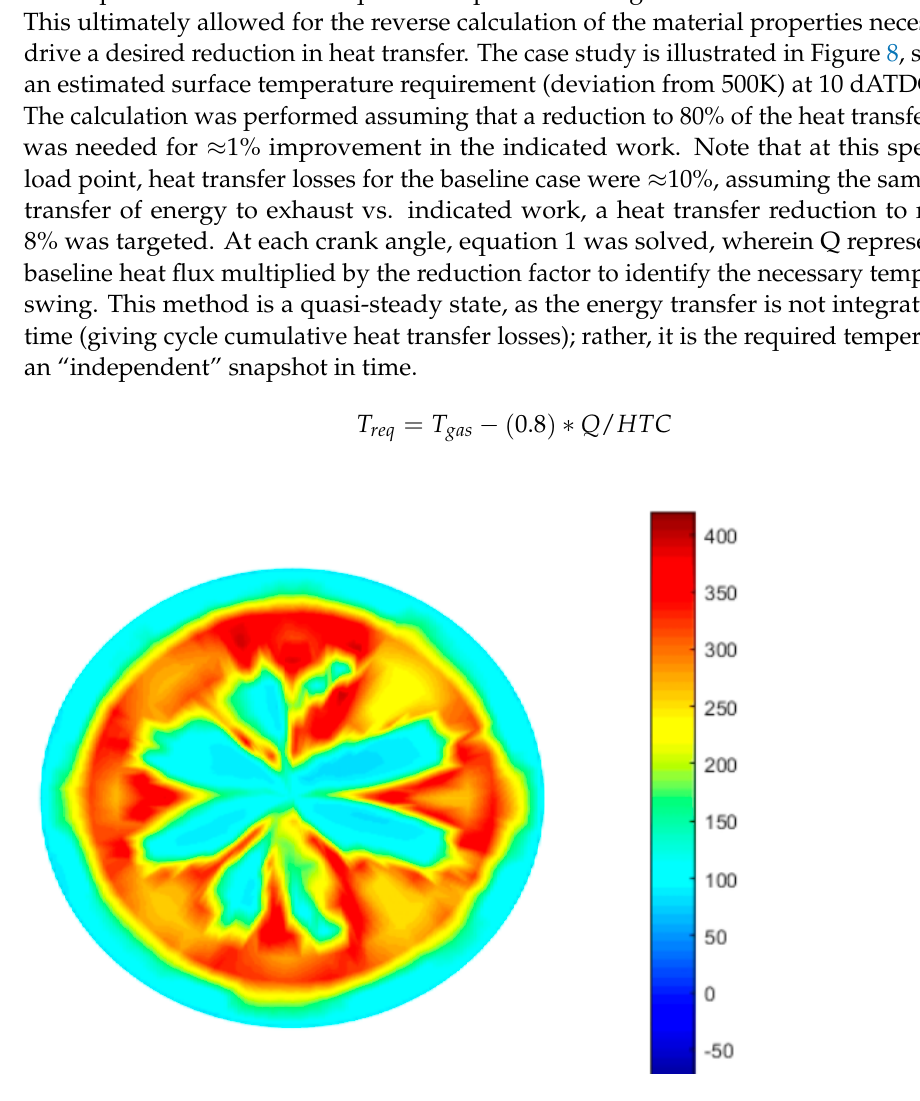
Figure 8. Required temperature swing (from 500K) to achieve a 20% reduction in heat flux at each nodal location, at crank angle 10 dATDC.